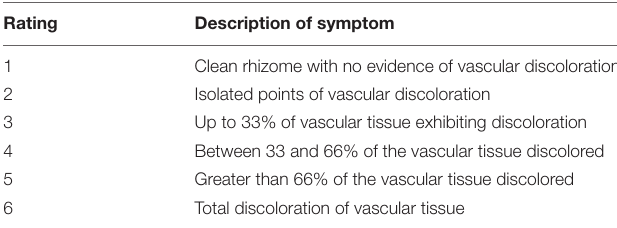
TABLE 1 | Disease severity rating scale for internal symptoms present in rhizome of banana plants caused by Fusarium oxysporum f.sp. cubense (Carlier et al., 2003).